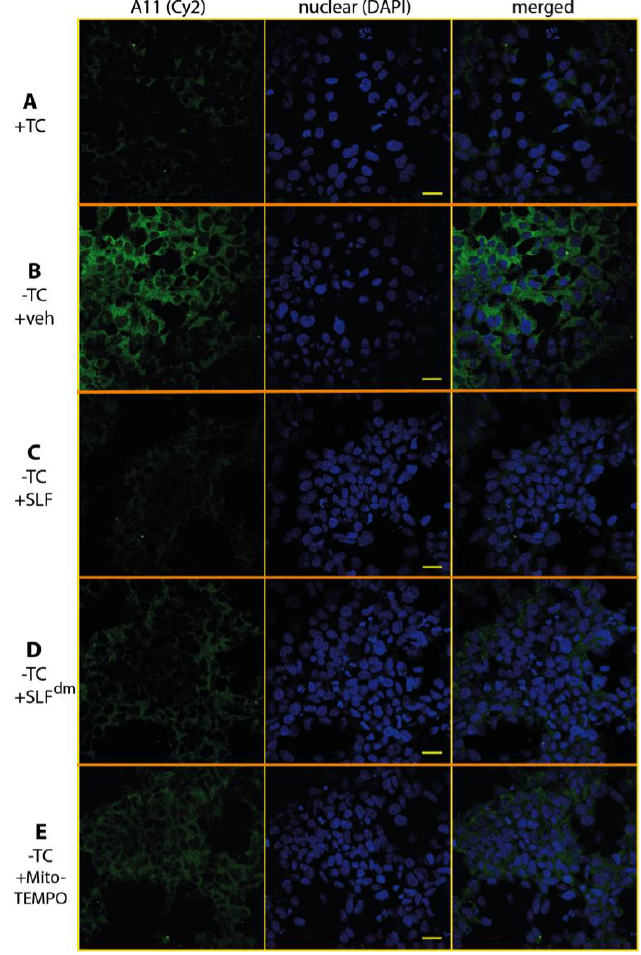
Figure 8. SLF greatly reduces the presence of intraneuronal oligomeric Aβ (AβO) in MC65 cells overexpressing APP. The presence of AβO was detected by the oligomer-specific antibody A11 (indicated by green Cy2 signal) in MC65 cells examined by confocal microscopy. In the absence of APP induction, there is no detection of intraneuronal AβO ( A ). With overexpression of APP, AβO staining is clearly evident ( B ). Addition of SLF to MC65 cells overexpressing APP results in a dramatic decrease in AβO ( C ). Relative to SLF, the ability of diamagnetic SLF to reduce AβO is markedly less ( D ), which suggests that ROS promotes Aβ generation and/or AβO formation. Row ( E ) shows that MitoTEMPO attenuates AβO only partially, which is consistent with the notion of the synergistic action of SLF (conformational effects and targeted antioxidant). In addition to the Cy2 images (left column), images for the DAPI nuclear stain (middle column) and merged DAPI-Cy2 images (right column) are shown. The scale bar represents 20 µ